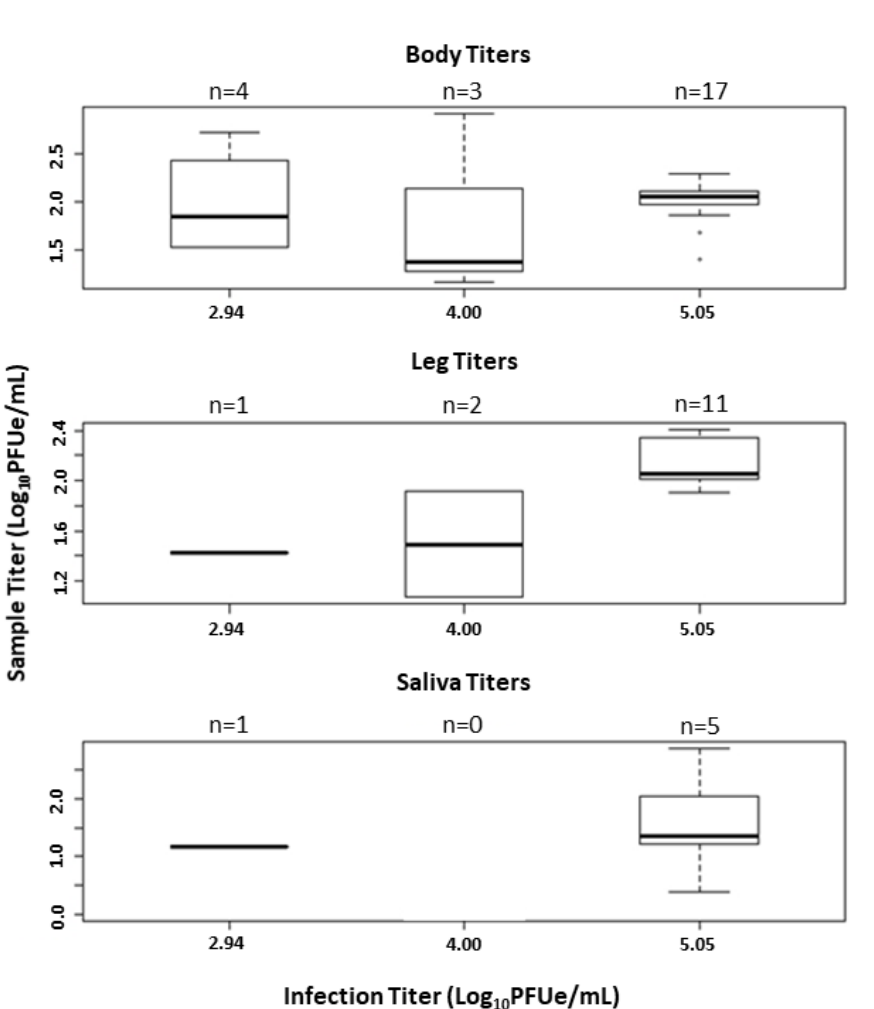
Figure 3. Viral titers of EHDV-2 in bodies, legs, and saliva of Culicoides insignis infected at three viral titers. Center lines of boxplots represent the median viral titer. Upper and lower extent of boxes represent the third and first quartile, respectively. Whiskers represent the estimated maximum and minimum values (1.5 × the interquartile length). Points outside of whiskers represent outliers. Plots represented by a solid horizontal line represent one data point for that treatment. No significant difference in viral titer was detected between treatments for body titers ( p = 0.30). Sample sizes for leg and saliva titers were low, excluding the possibility of meaningful statistical comparison.